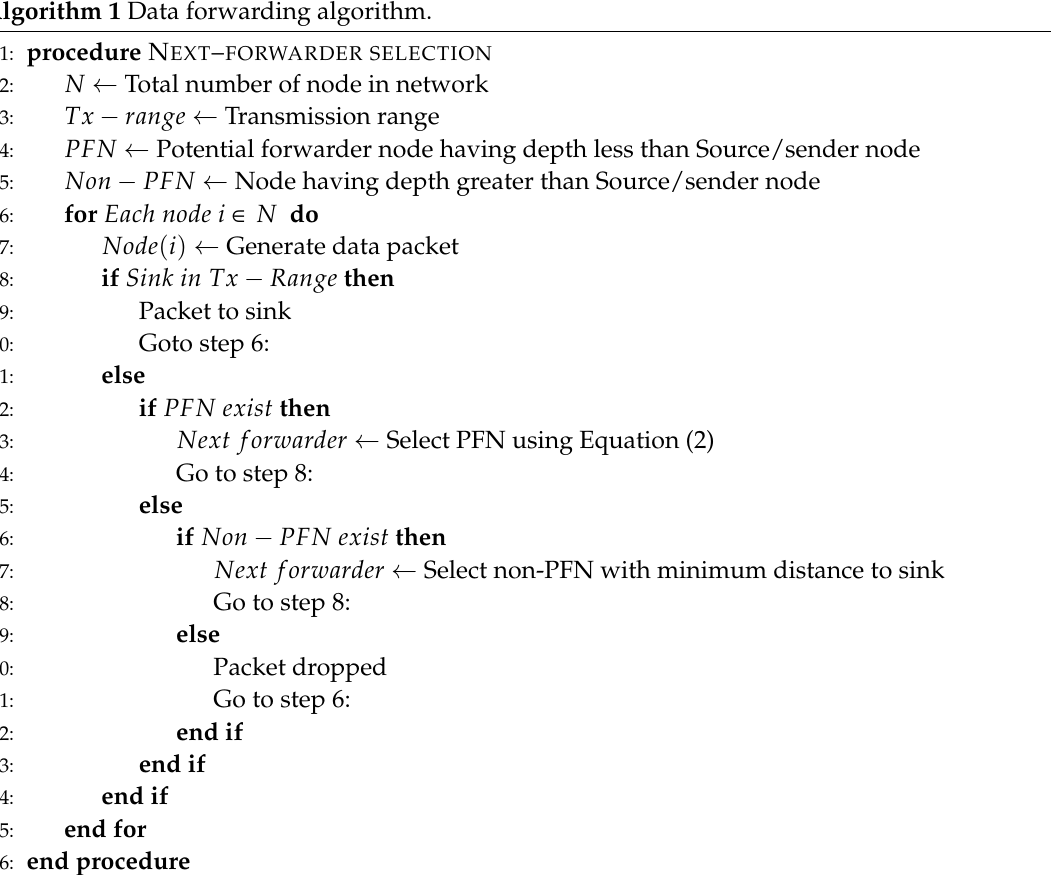
Algorithm 1 Data forwarding